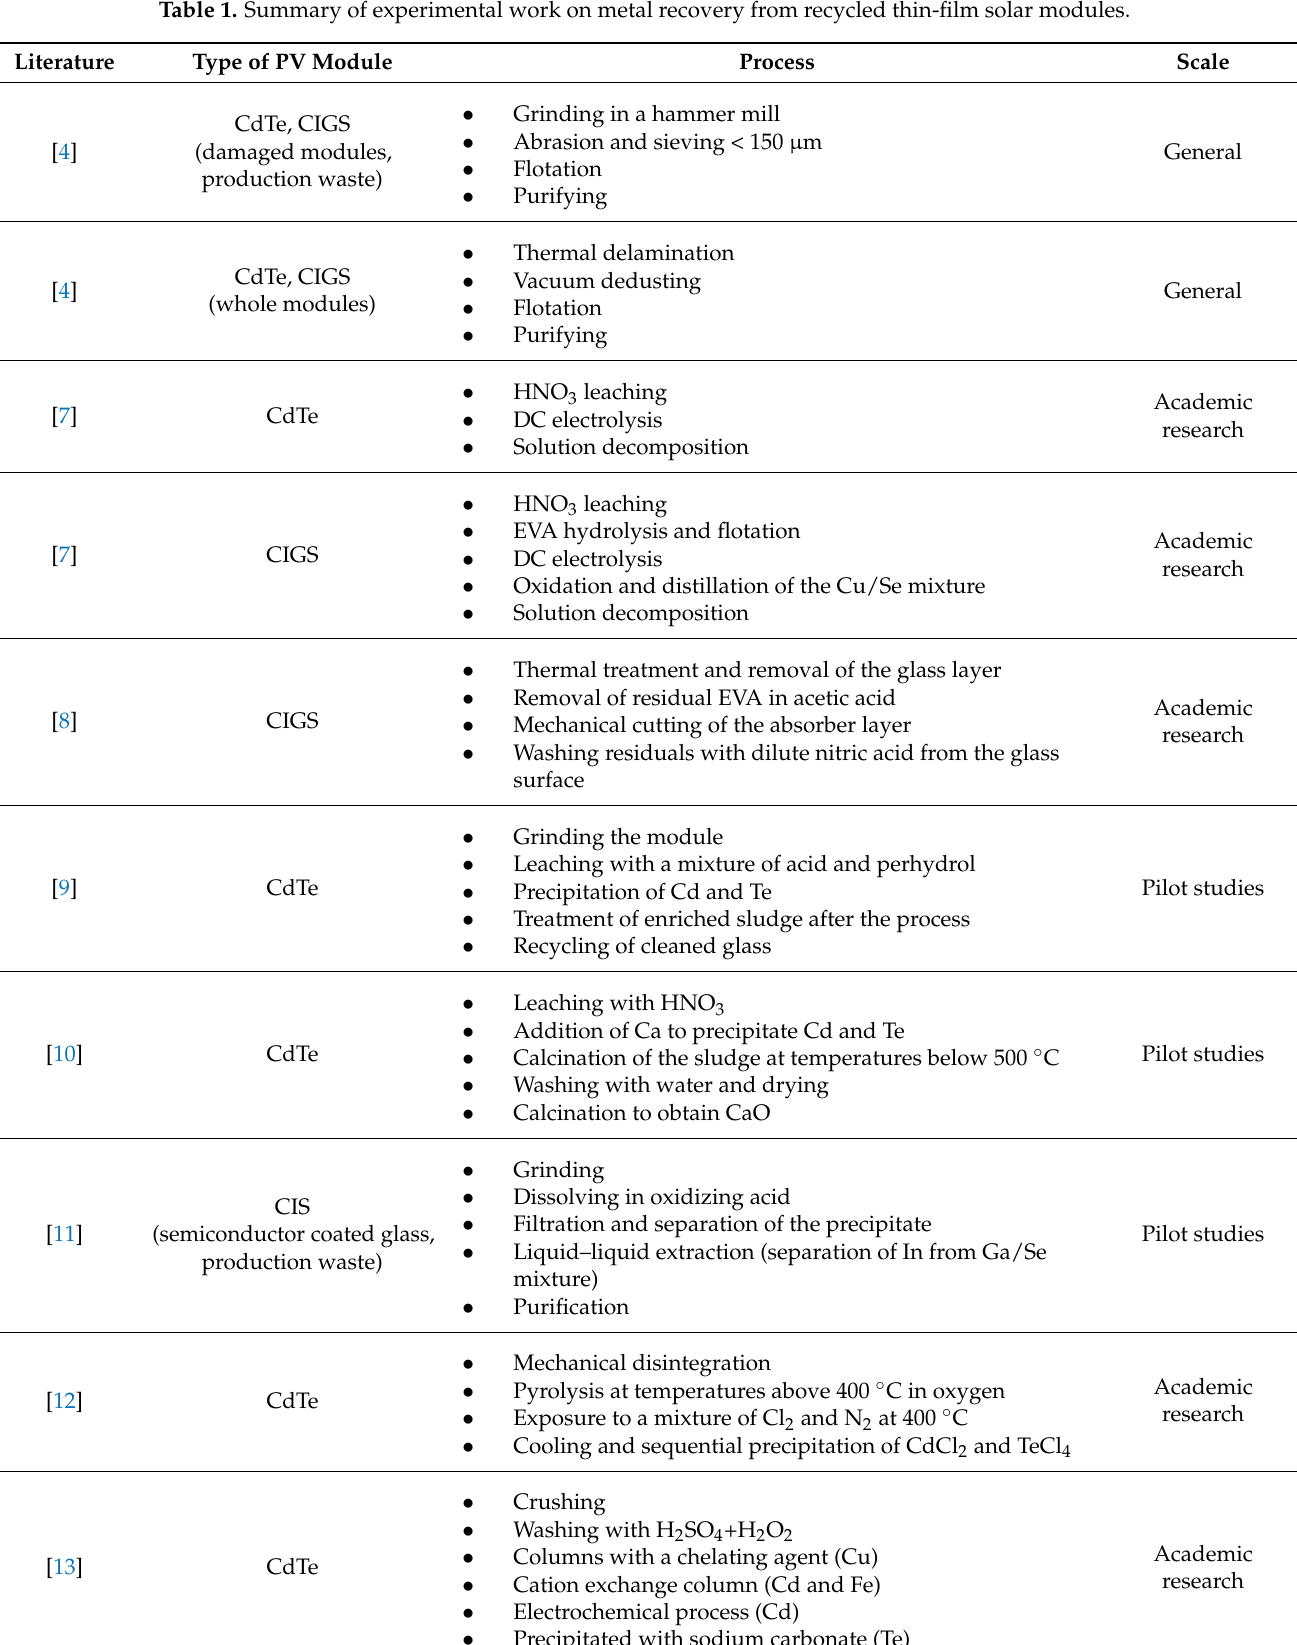
Table 1. Summary of experimental work on metal recovery from recycled thin-film solar